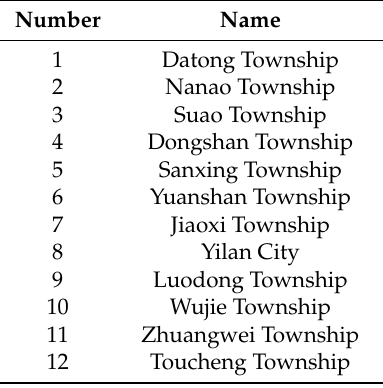
Figure 5. The study area and its administrative districts. Table 1. The corresponding number for each administrative district of the study